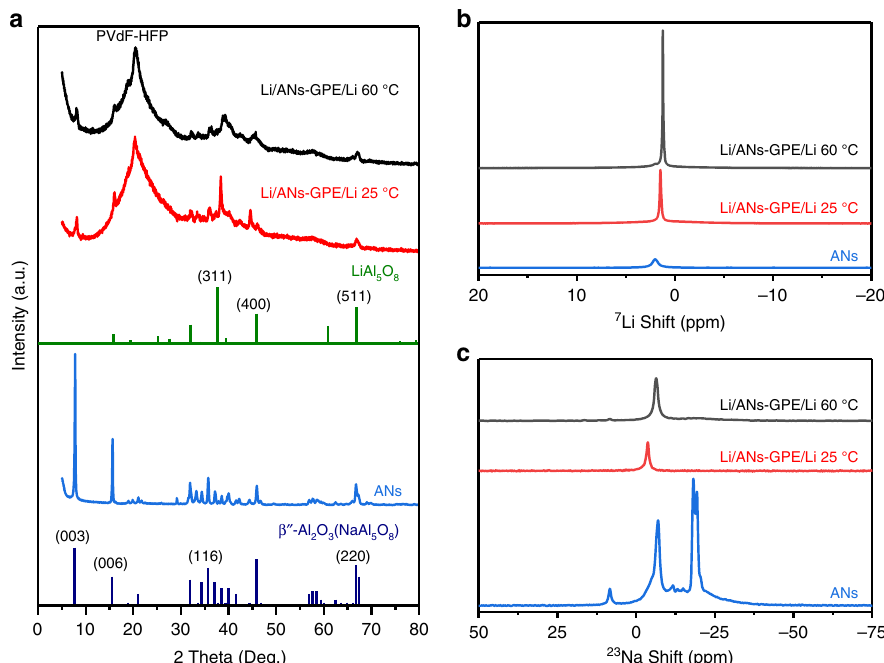
Fig. 5 Characterization of ANs before and after cycling in Li/ANs – GPE/Li cells. a XRD patterns and ( b ) 7 Li and ( c ) 23 Na NMR spectra of ANs and cycled ANs – GPE in Li/ANs – GPE/Li cells at 25 °C and 60